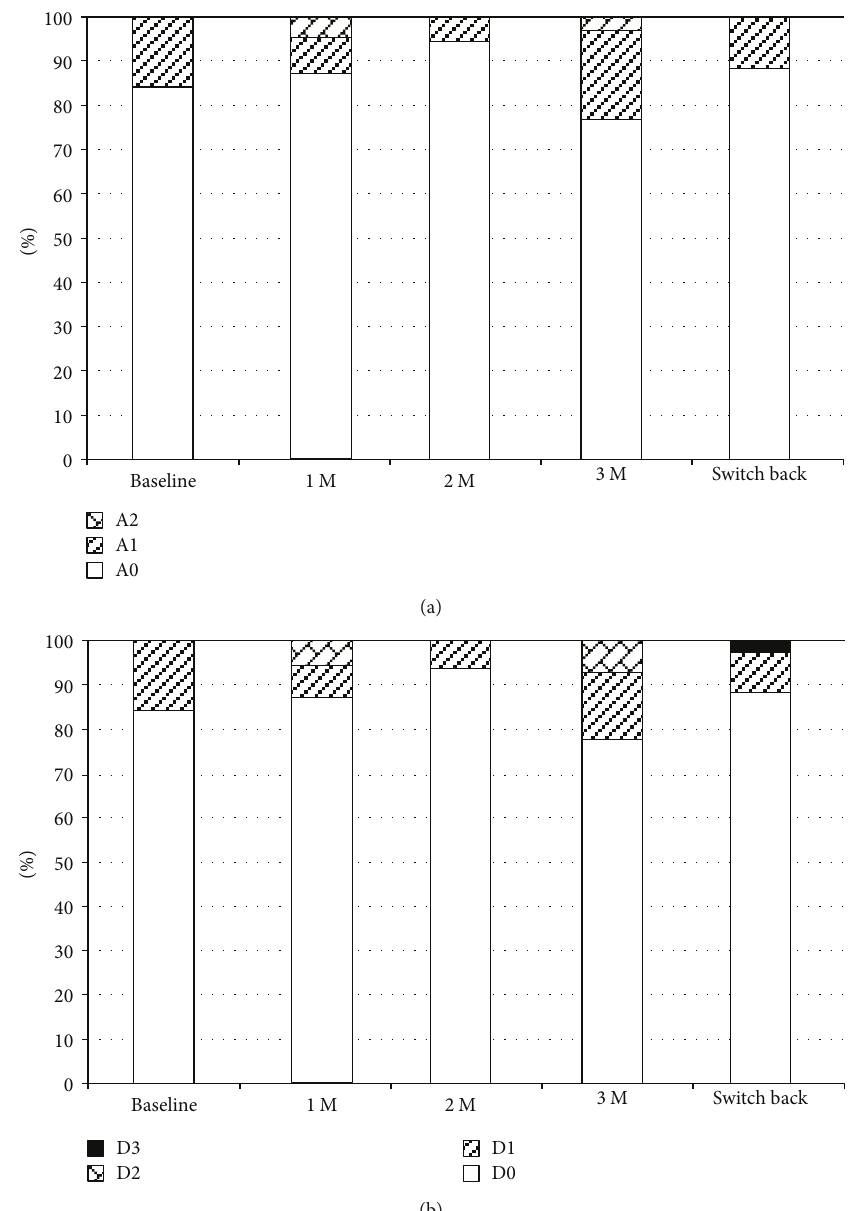
Figure 6: Changes in corneal epithelial defects. (a) Area of corneal epithelial defects. (b) Density of corneal epithelial defects. A: area; D: density; M: